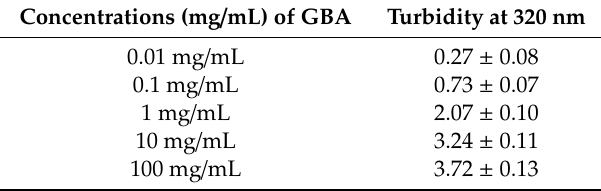
Table 1. Turbidity measurement at 320 nm for increasing concentrations (0.01, 0.1, 1, 10, and 100 mg / mL) of goose bone ash (GBA) in water after incubation at 37 ◦ C for 30 min and supplementation with 10% fetal bovine serum